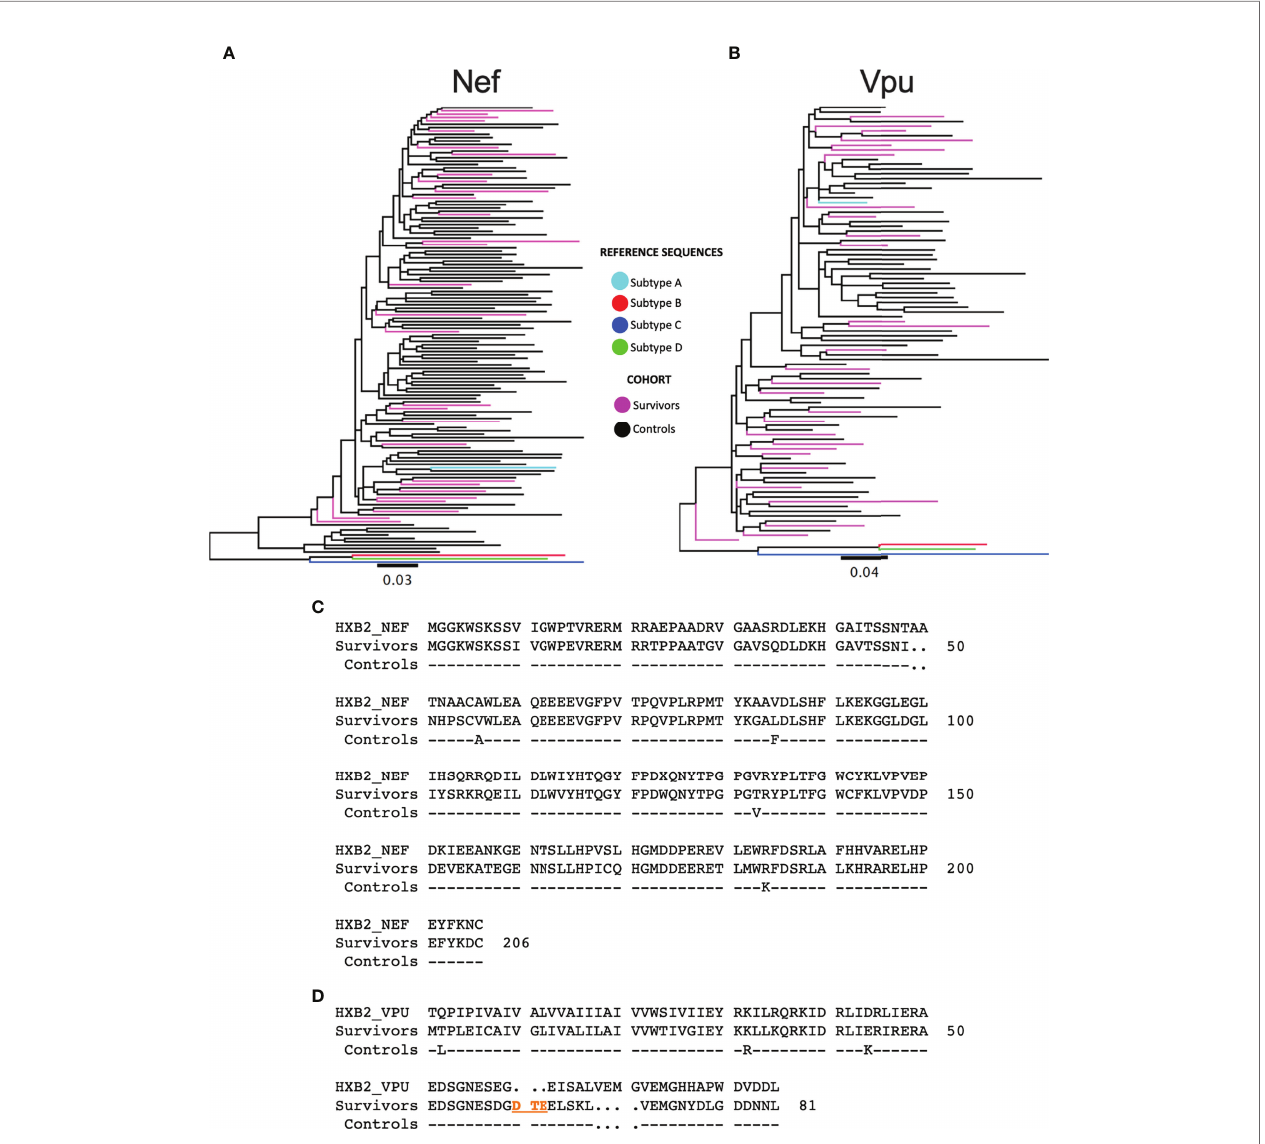
FIGURE 2 | Phylogenetic trees of subtype A sequences from survivors and controls. (A) Phylogeny inferred from alignments of HIV-1 subtype A nef sequences from LTS and control participants, along with HIV-1 subtype (A – D) reference sequences. Sequences are colored by cohort (LTS in pink, controls in black). The tree is midpoint-rooted. Scale in estimated nucleotide substitutions per site. (B) Corresponding phylogeny for HIV-1 subtype A vpu sequences. (C) nef consensus sequences from LTS and control cohorts aligned to HXB2 subtype B reference. Residue numbering is based on HXB2. (D) vpu consensus sequences from LTS and control cohorts aligned to HXB2 subtype B reference. Residues 60-62 (DTE) shown in orange were present in the native subtype A sequences, but missing in HXB2. Likewise, HXB2 contains an insertion at residues 65-68, which were excluded from numbering. As such, the residue numbering for Vpu is based on the participant